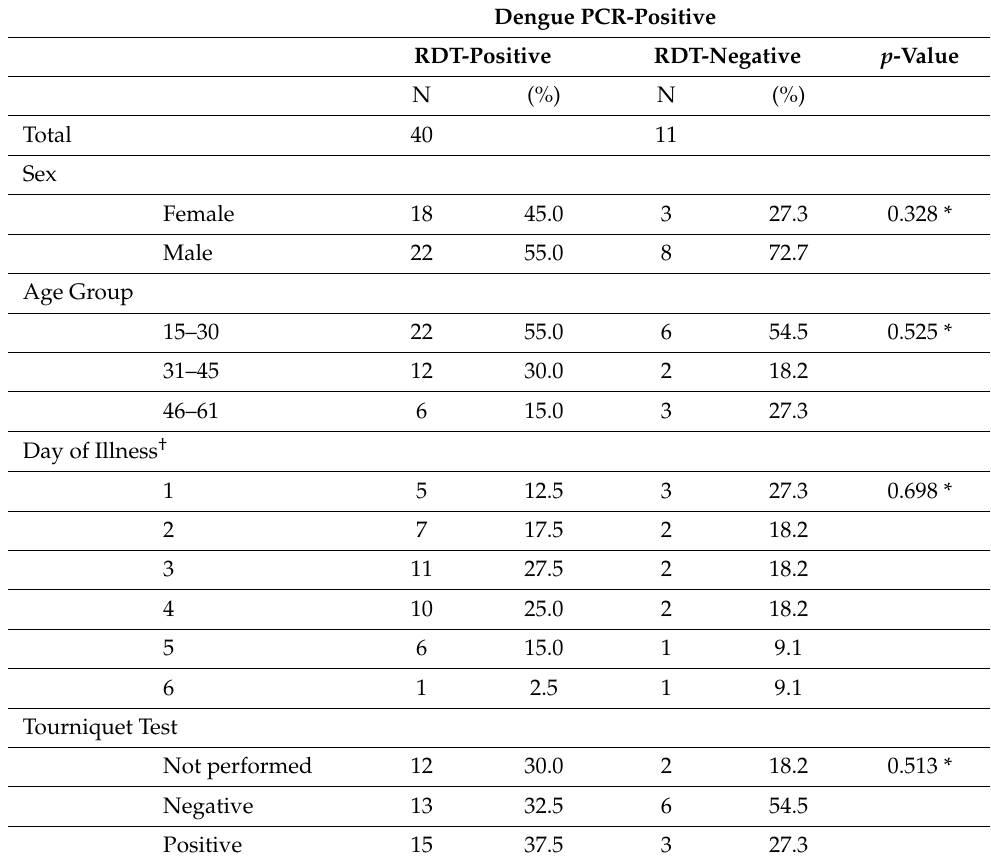
Table 4. Characteristics of patients with false negative RDT-NS1 and